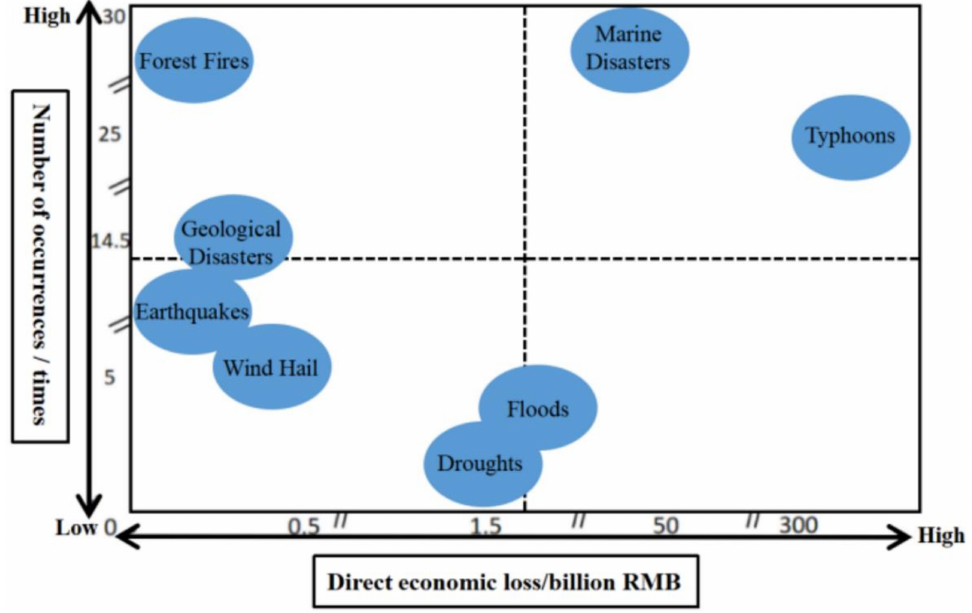
Figure 1. Frequency of natural disasters and direct economic losses in Hainan Province,